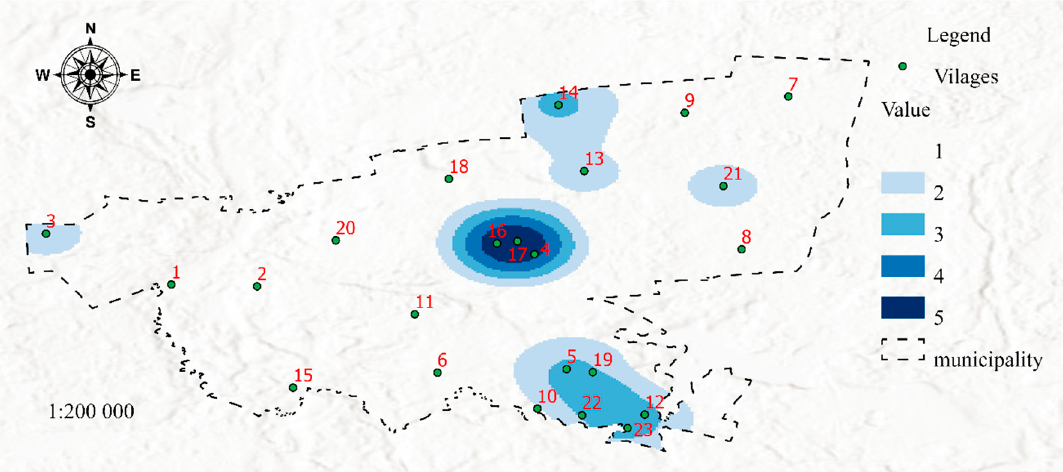
Figure 5. Map 3—Visualization of areas in need of personal assistance (dataset 3). Source: Own elaboration.